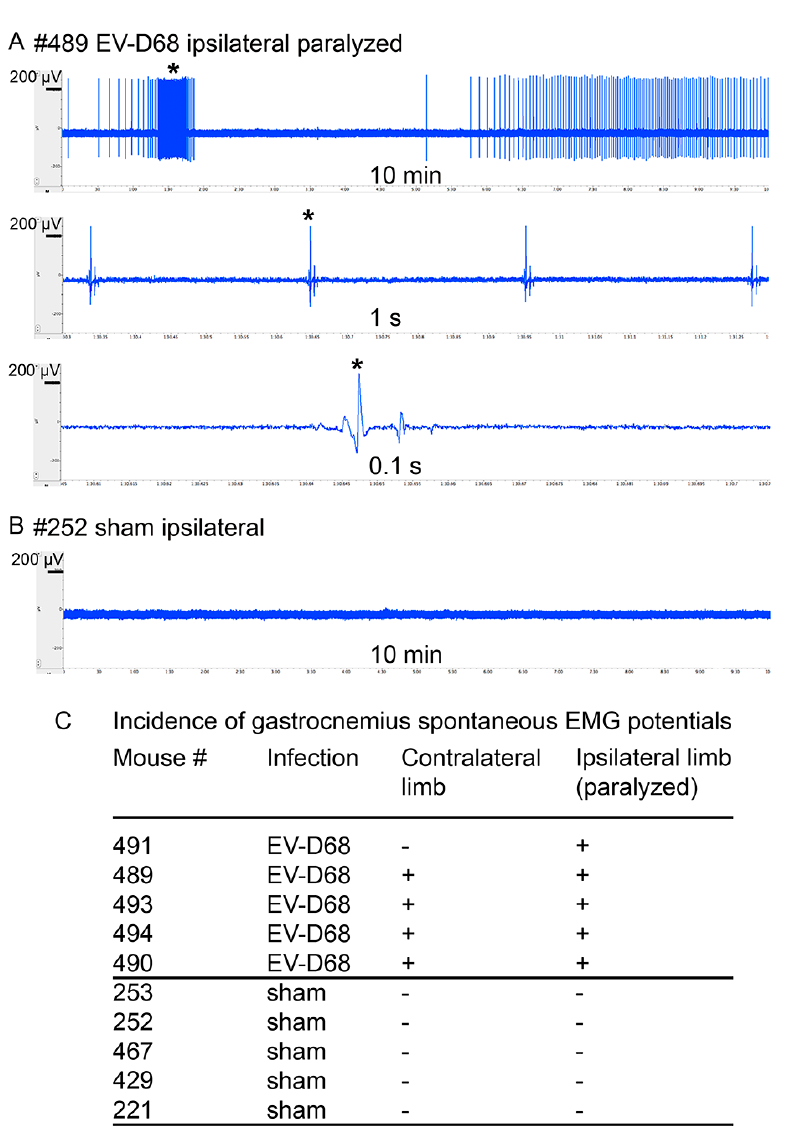
Figure 5. Spontaneous electromyographic (EMG) fibrillation potentials of gastrocnemius muscle from AG129 mice infected with EV-D68 six weeks after onset of paralysis. * indicates same time reference between tracings. ( A ) Paralyzed ipsilateral hindlimb of #489 infected with EV-D68 had fibrillation; ( B ) Ipsilateral hindlimb of #252 sham mouse did not have fibrillation; ( C ) Incidence of fibrillation among EV-D68-infected and sham-infected mice. + symbol indicates presence of spontaneous EMG. − symbol indicates absence of spontaneous EMG.